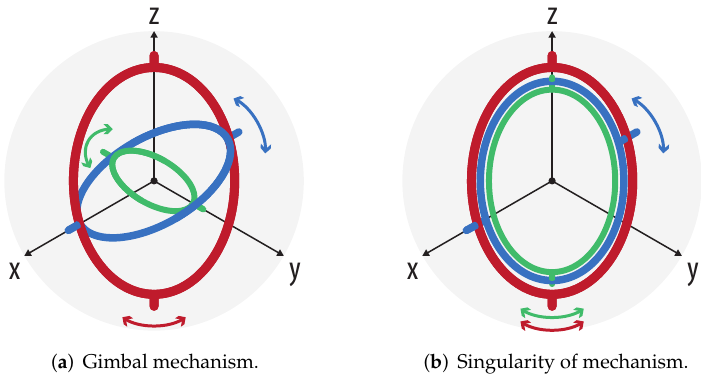
Figure 5. Kinds of rotations.